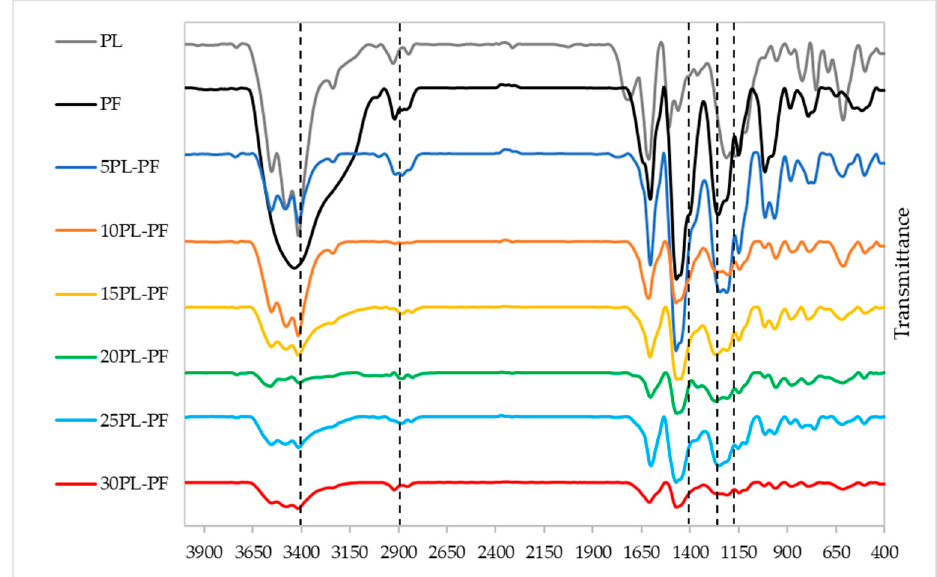
Figure 5. FTIR spectrum of the PL − PF resins from 5 to 30% phenol substitution rate. According to Lai and Idris [29] and Talabi et al. [30], peaks at around 1211–1245 cm − 1 indicate the presence of guaiacyl (G) propane units, whereas 1325–1375 cm − 1 indicates the presence of syringyl (S) propane units. From the FTIR spectrum of PL − PF resins, it was discovered that all PL − PF resins have intense peaks around 1211–1245 cm − 1 and no peak at 1325–1375 cm − 1 , indicating that all PL − PF resins are rich with G-propane units, thus making them suitable for phenolic resin